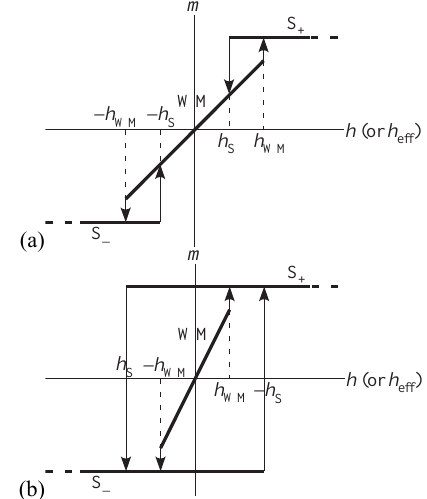
Figure 4: Magnetization property of unit cell: (a) when − h WM < h S and (b) when h S < − h WM .